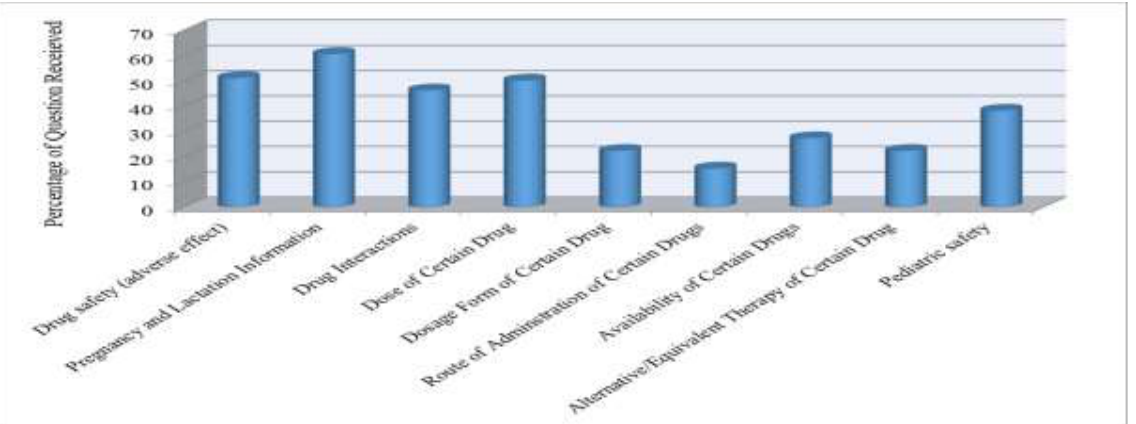
Figure 5. Questions the participants were received and looked for appropriate answer in different resources during working in the